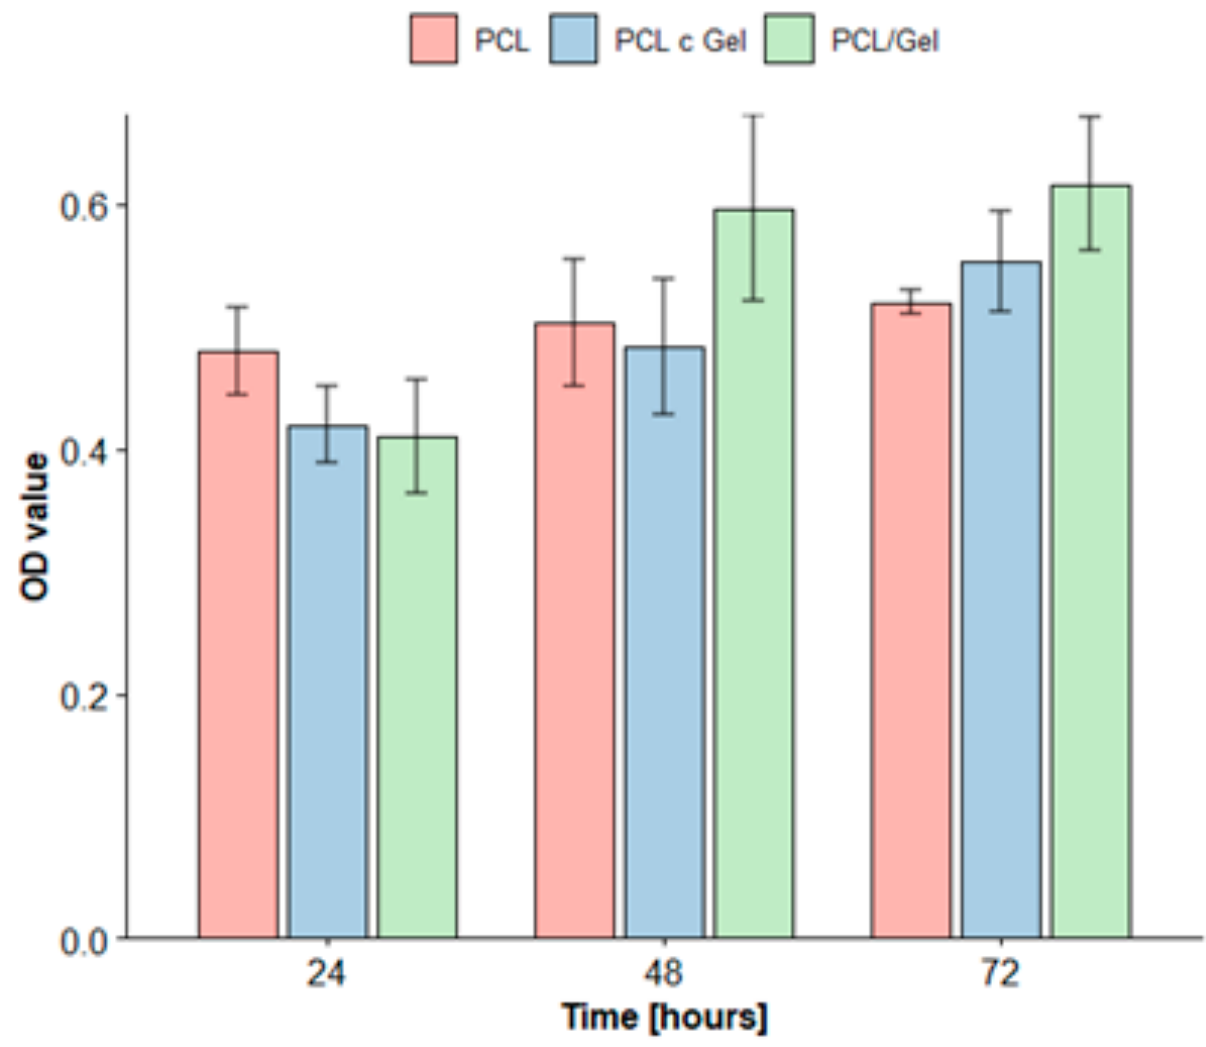
Figure 5. MTT results of MEF on the PCL, PCL gelatin coating and PCL/gelatin nanofibers after 24, 48 and 72 h.